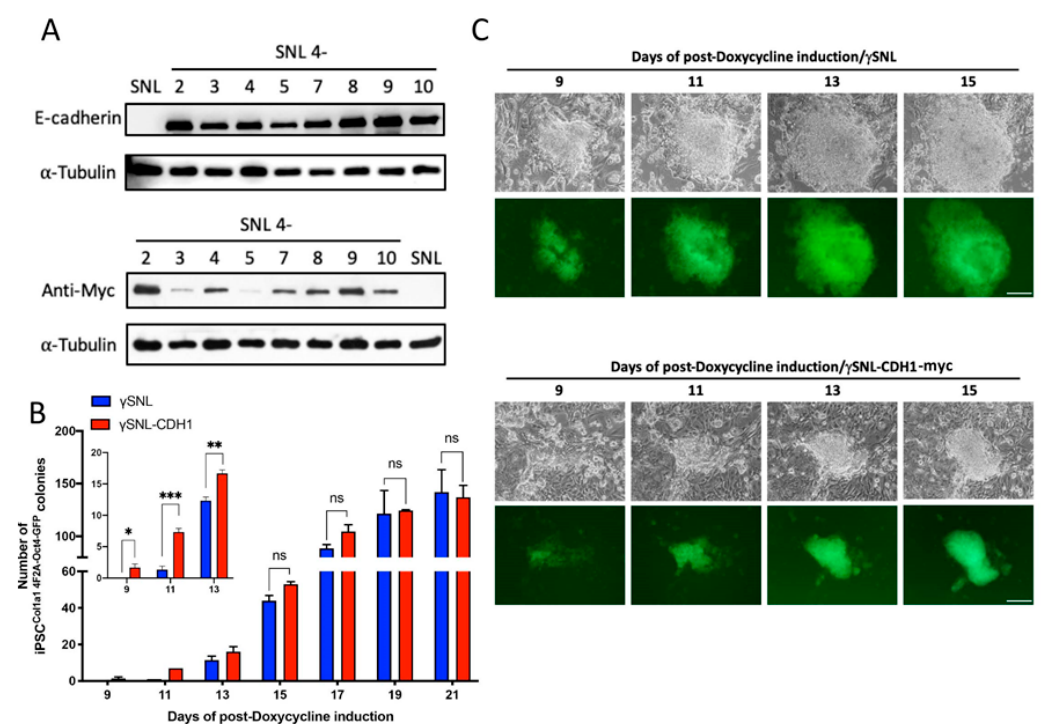
Figure 1. E-cadherin produces in trans facilitation of early-stage somatic reprogramming. ( A ) The expression of E-cadherin in different engineered SNL-CDH1-MYC cell lines. Each SNL-CDH1-MYC line was subjected to western blot analysis with anti-E-cadherin and anti-MYC antibodies. ( B ) Quantitative analysis of the Oct4-GFP-positive colonies during iPSC induction (n = 3). ( C ) Time-lapse photographs of iPSC colony formation from either γ SNL or γ SNL-CDH1-MYC feeder cell-seeded MEF Col1a1 4F2A Oct4-GFP cells in iSF medium. Fluorescence microscopy was performed on the 9th to 15th days. The iPS clones in the upper panel were seeded with the parental SNL feeder cells, whereas the lower panel shows clones with the SNL-CDH1-MYC feeder cells. The scale bar denotes 50 µm. *, p < 0.05; **, p < 0.005; ***, p < 0.0005; ns, not significant.